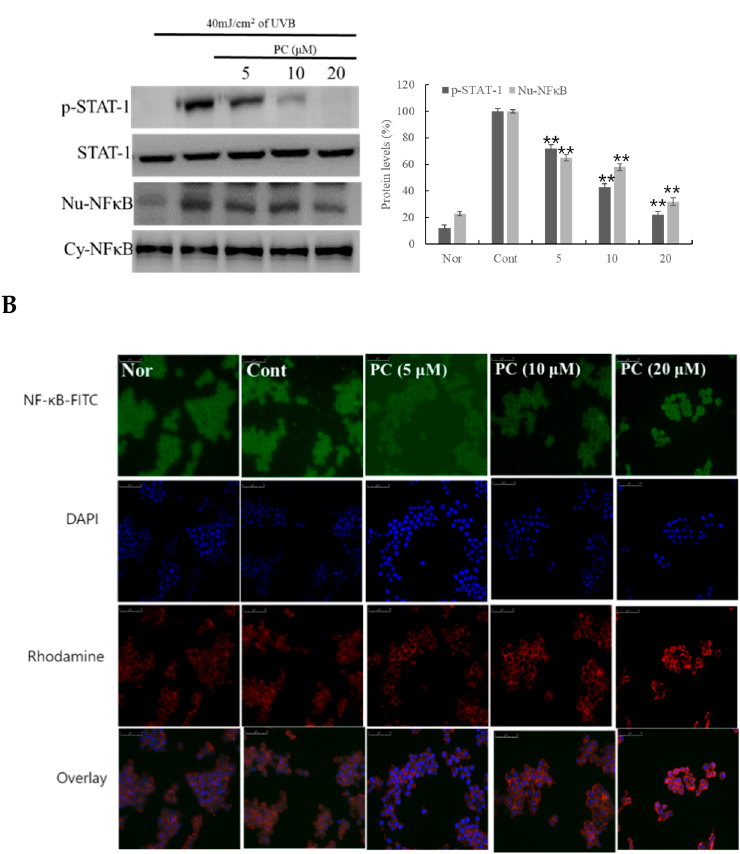
Figure 5. Effect of PC (1) treatment on STAT and NF- κ B protein expression in HaCaT cells. HaCaT cells were pre-treated with different concentrations of PC (1) (5, 10, 20 μ M) for 1 h. The cells were further stimulated with 40 mJ/cm 2 UVB light. After 6 h, the cells were harvested, and relative protein levels were determined. Histograms show the densitometric data of STAT and NF- κ B protein normalized to GAPDH. Each value represents the mean ± SD of three individual experiments. Nor: Non-treated cell group (0 h), Cont: 40 J/cm 2 UVB-treated cell group. A : STAT and NF- κ B protein levels, B : NF- κ B-FITC, DAPI, Rhodamine and Overlay expression. Data are expressed as the means ± S.D., n = 3. * p < 0.001 and ** p < 0.0001 compared to the control group.